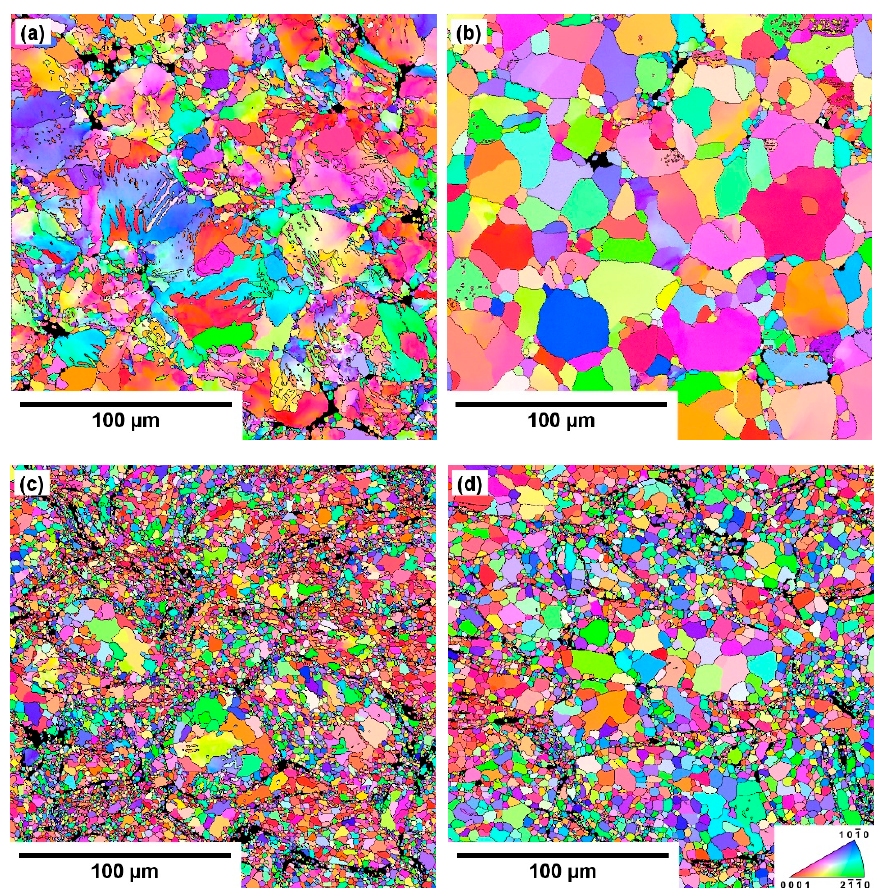
Figure 3. EBSD orientation maps of ( a ) GA-400C, ( b ) GA-550C, ( c ) M-400C and ( d ) M-550C samples. IPF colored along the sintering load direction.